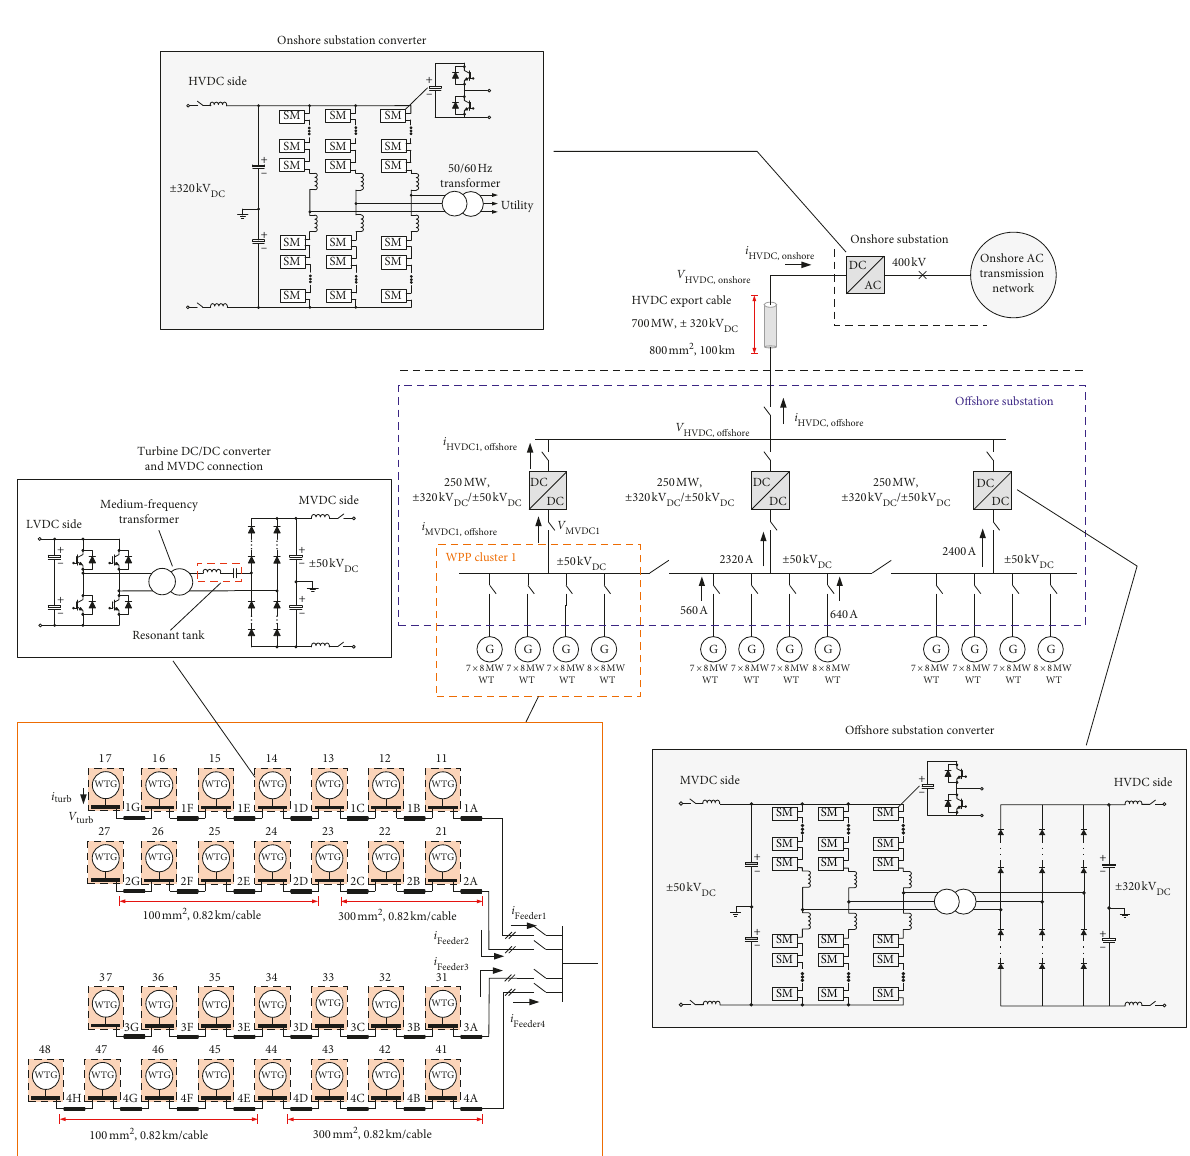
Figure 2: Single line diagram of example 700 MW offshore DC wind farm